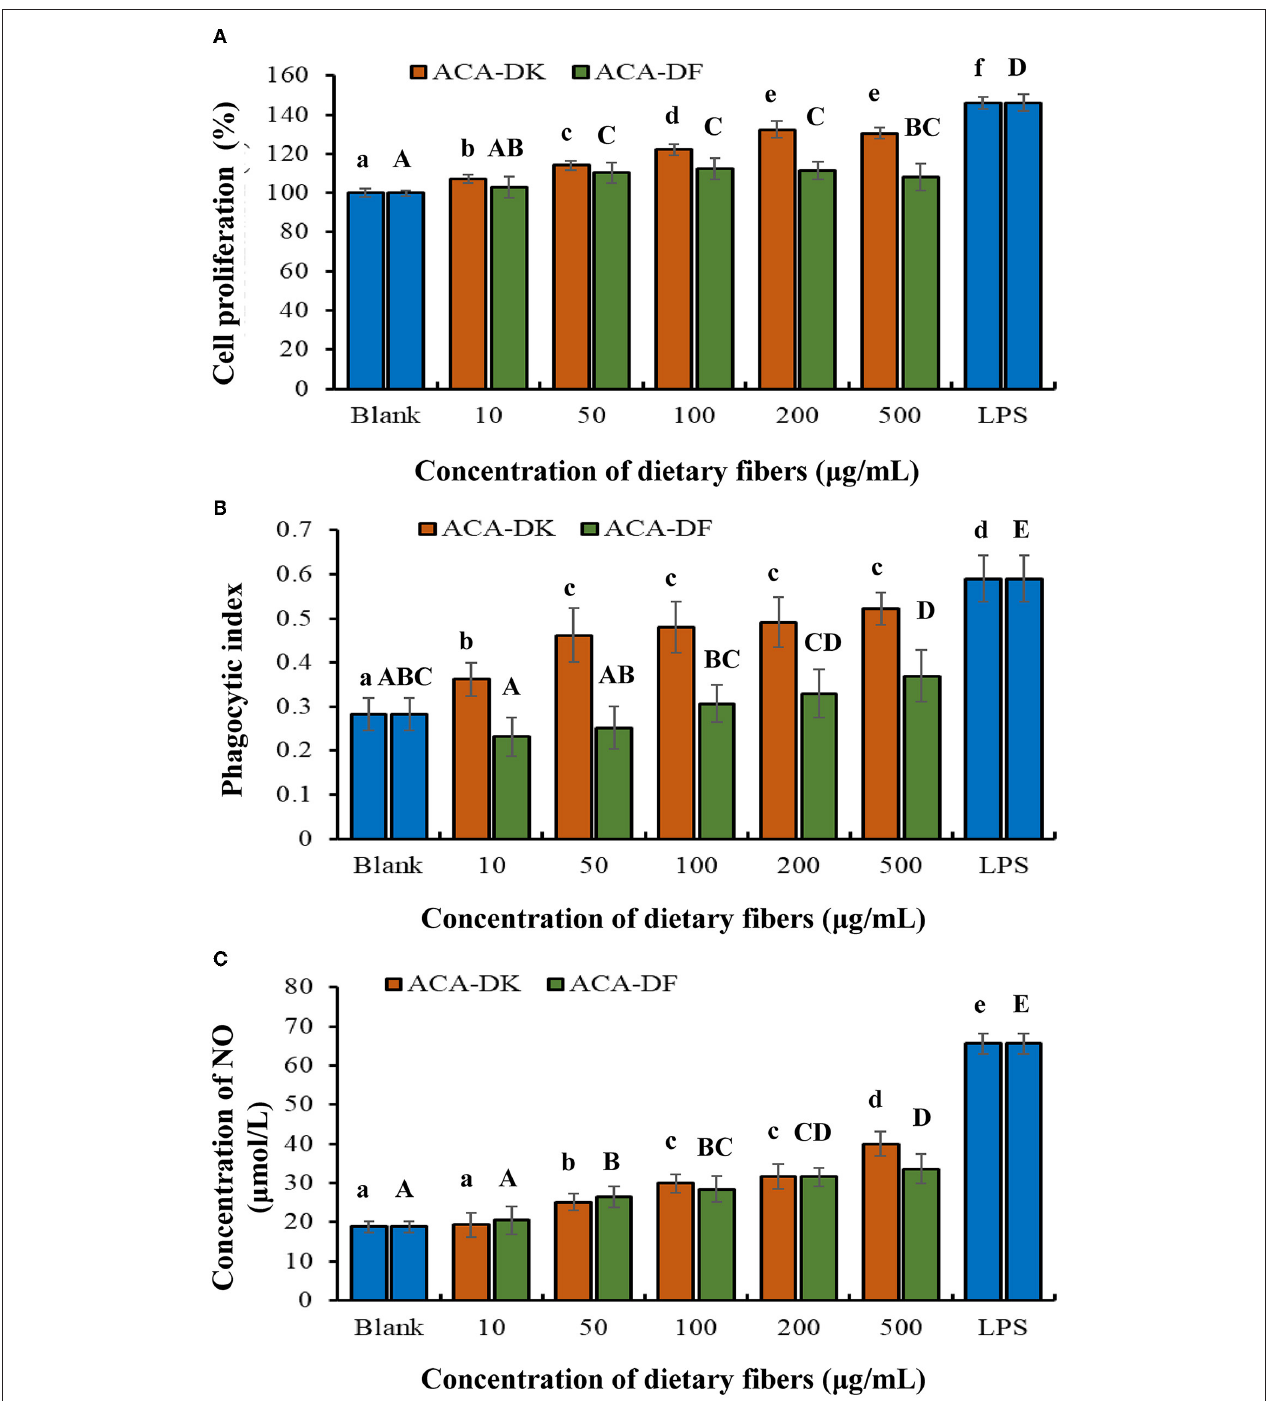
FIGURE 5 | Effect of ACA-DK and ACA-DF on the (A) proliferation, (B) phagocytic activity, and (C) NO production of RAW 264.7 cells. The cells were treated with increasing concentrations of ACA-DK and ACA-DF (10, 50, 100, 200, 500 µ g/mL) for 24h, respectively; LPS (1 µ g/mL) as a positive control. Results of experiments are express as mean ± SEM for each experimental group ( n = 6). The significance of differences between the data was assessed using one-way ANOVA by Dunnett’s tests, with the level of significance set at P < 0.05.